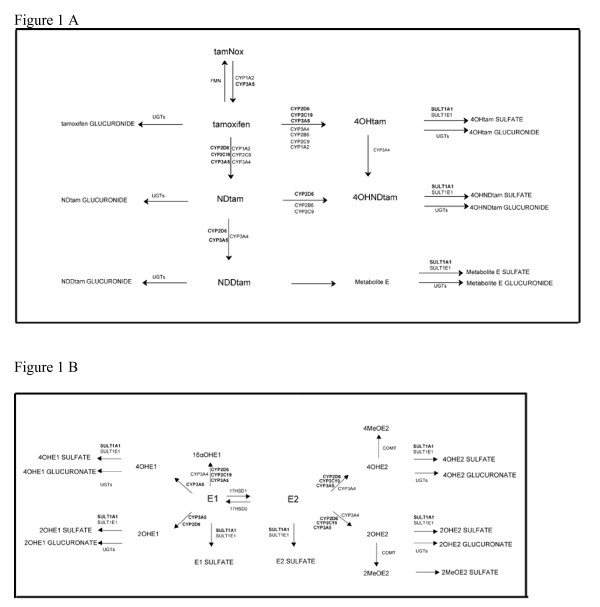
Schematic representation of (A) tamoxifen and (B) estradiol metabolism and the enzymes involved. 4OHtam, 4-hydroxytamoxifen; 4OHNDtam, 4-hydroxy-N-demethyltamoxifen; NDtam, N-dedimethyltamoxifen; NDDtam, N-dedimethyltamoxifen; tamNox, tamoxifen-N -oxide; CYP, cytochrome P450; SULT, sulfotransferase; UGT, Uridine 5'-diphospho-glucuronosyltransferase; E2, estradiol; E1, estrone; E1S, estrone sulphate; 4OHE2, 4-hydroxyE2; 2OHE2, 2-hydroxyE2; 4MeOE2, 4-methoxyE2; 2MeOE2, 2-methoxyE2; 4OHE1, 4-hydroxyE1; 2OHE1, 2-hydroxyE1; 4MeOE1, 4-methoxyE1; 2MeOE1, 2-methoxyE1; 16αOHE1, 16α-hydroxyE1; Catechol-O-methyl transferase, COMT. Bolded texts indicate tamoxifen and estrogen metabolizing enzymes investigated.